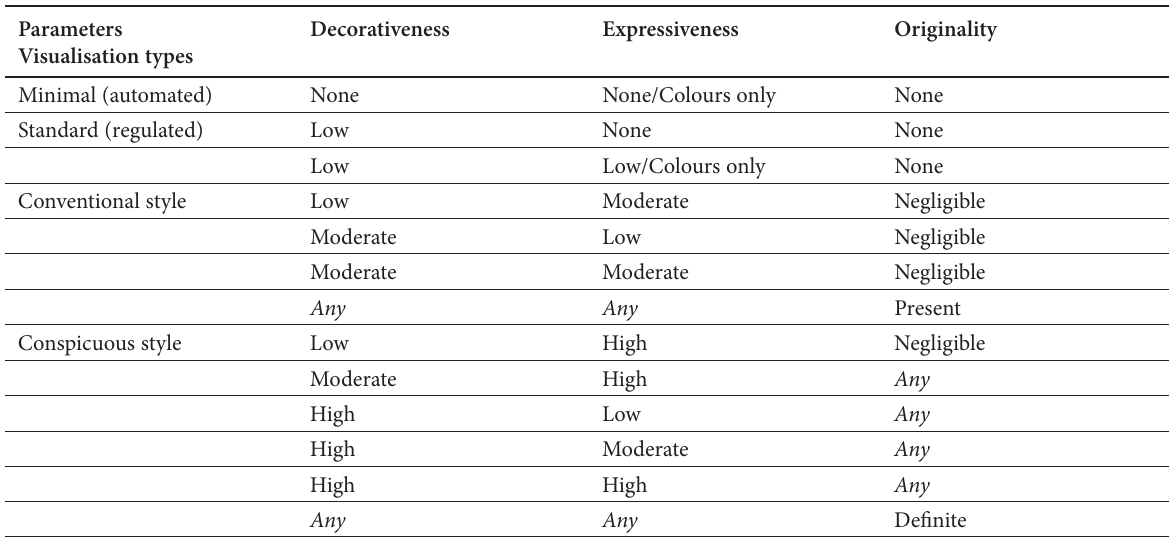
Table 2. Stylistic parameters and stylistic expression of maps